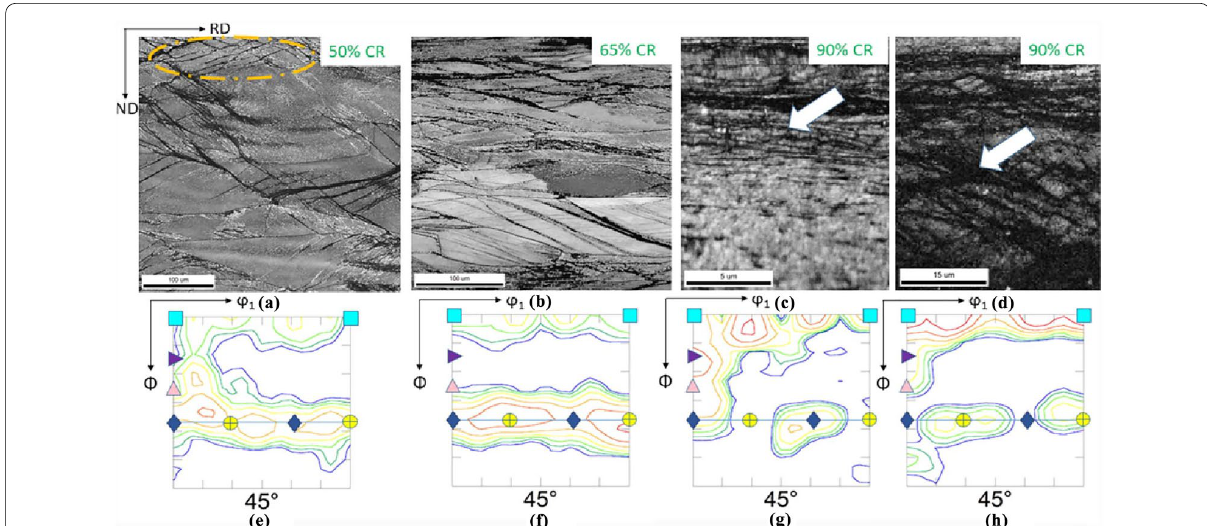
Figure 21 Microstructures of HfZrTiTaNb RHEA after different cold-rolling thickness reductions [95] ( a ) 50%; ( b ) 65%; ( c ) and ( d ) 90%; ( e – h ) showing corresponding φ2 45° section of the ODFs =